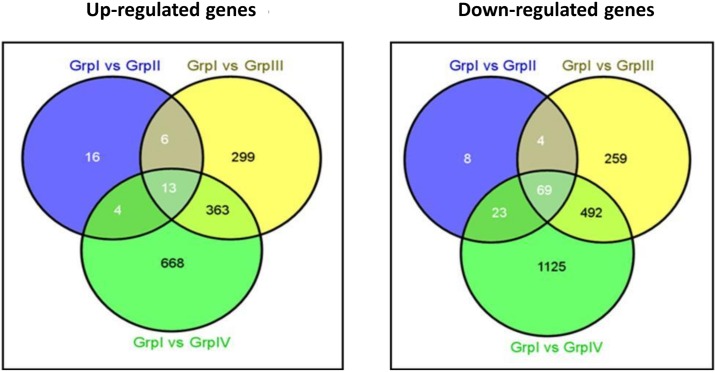
Venn diagram showing common as well as unique genes expressed in different group comparisons.Genes showing ≥ 1.3 fold change was considered for analysis.